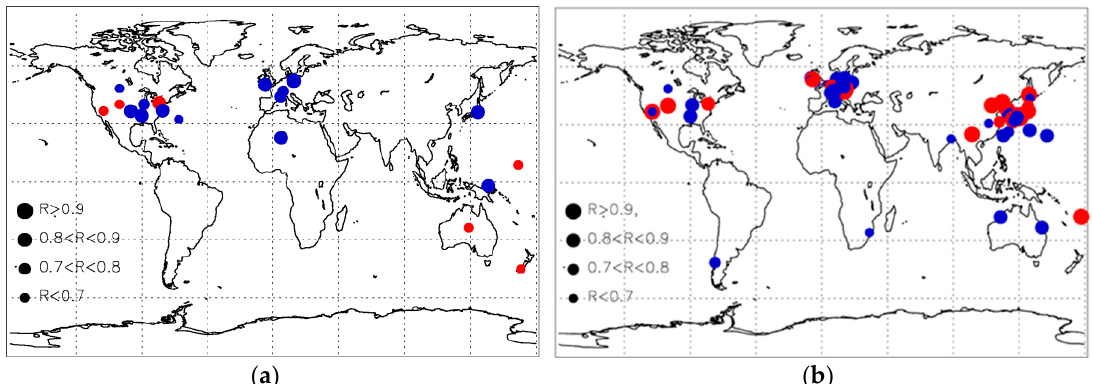
Figure 3. Comparison between model-computed tendencies of SSR anomalies ( ∆ SSR) during 2001–2009 and similar anomalies of the Baseline Surface Radiation Network (BSRN) ( a ) and the Global Energy Balance Archive (GEBA) ( b ) station measurements. Blue and red circles indicate BSRN and GEBA stations for which the sign of tendencies of model-computed and station-measured SSR anomalies ( ∆ SSR) agree and disagree, respectively. The size of circles indicates the magnitude of computed correlation coefficients R between model-computed and ground-measured SSR anomalies.